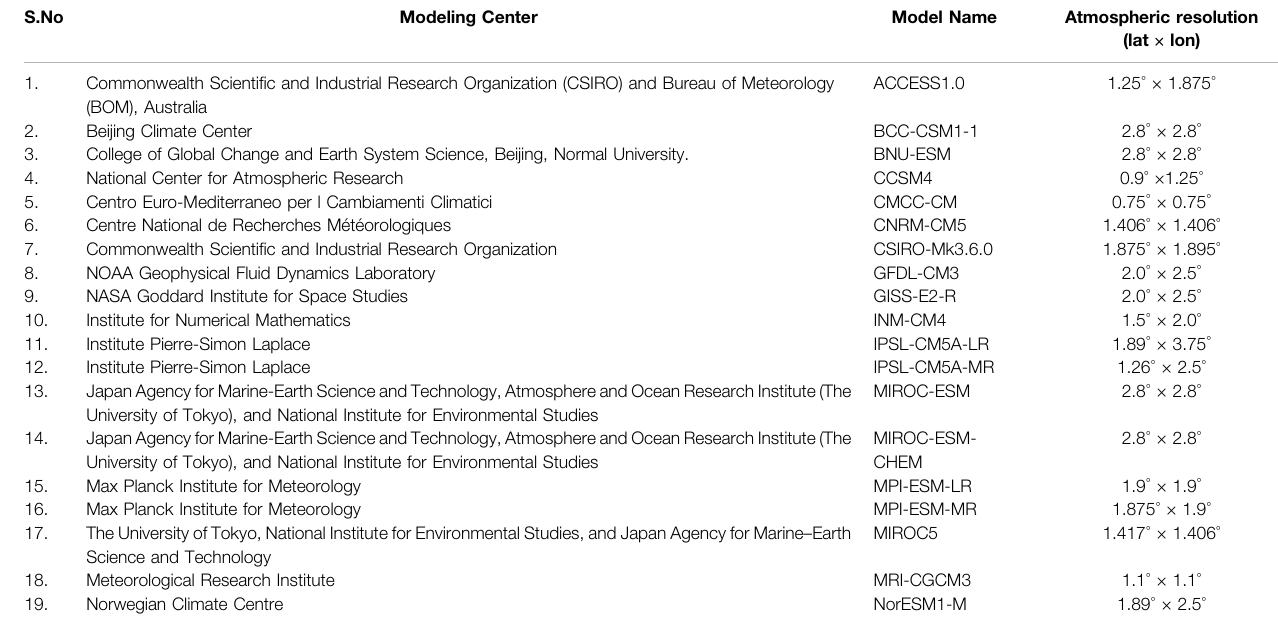
TABLE. 1 | List of CMIP 5 Models used for the